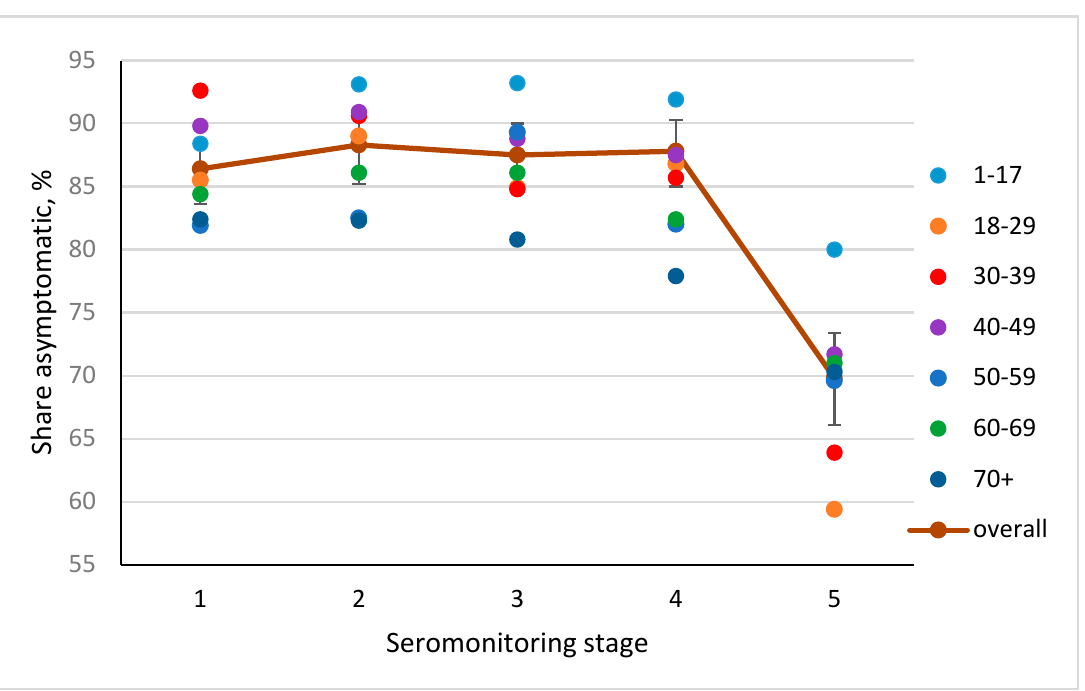
Figure 5. Share of asymptomatic forms among Nc–seropositive volunteers. The solid curve is the median share of seropositive volunteers with asymptomatic infection. Key: black vertical lines— [IQR]; colored dots—averaged values in each age group. Age groups of seropositive, asymptomatic volunteers are in years. See Table S4.